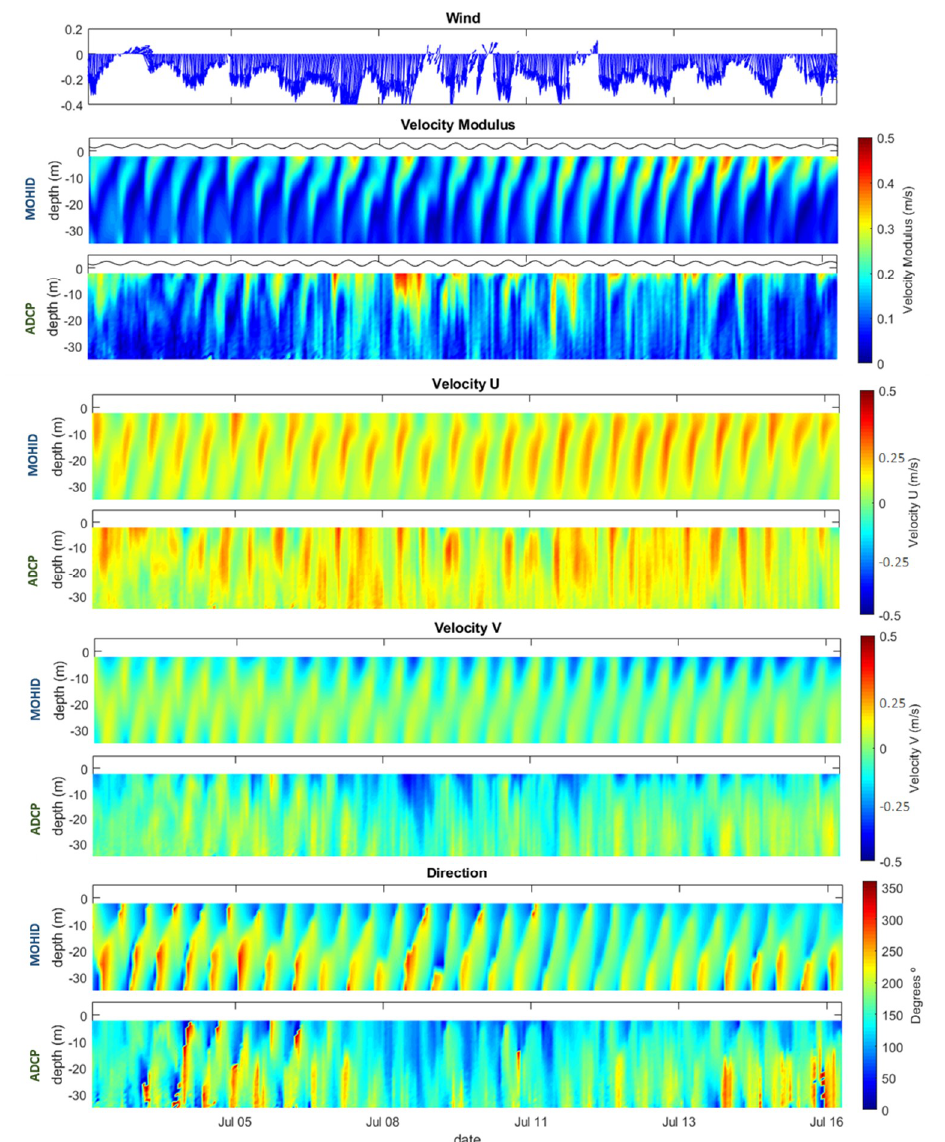
Figure 6. Profiles comparison of the velocity module, velocity components u and v and directions between MOHID Water results ( top ) and ADCP data ( down ) in function of depth and time; and wind time‐series. Data obtained off Cascais between 2 and 17 July 2009. For both observations and modelling results, the output was of 15 min.